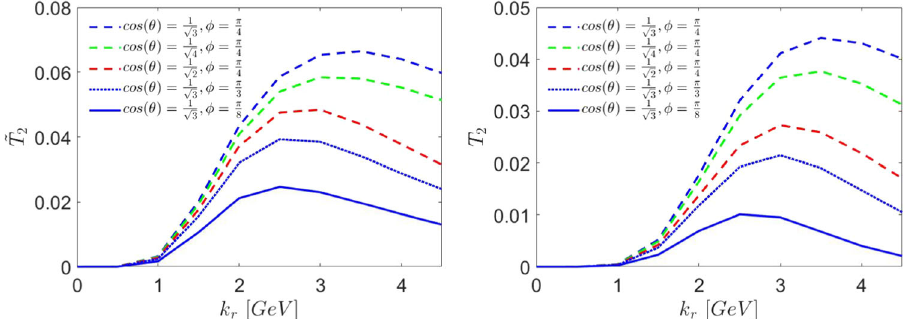
Fig. 6 The integrals T 2 and ˜ T 2 for different directions, θ,φ = const , k r is